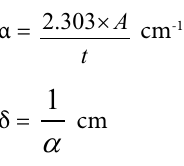
photocatalyst, Band gap plot of TiO synthesized under (b) pH-2, (c) pH-5, (d) pH-9 2 2 and (e)